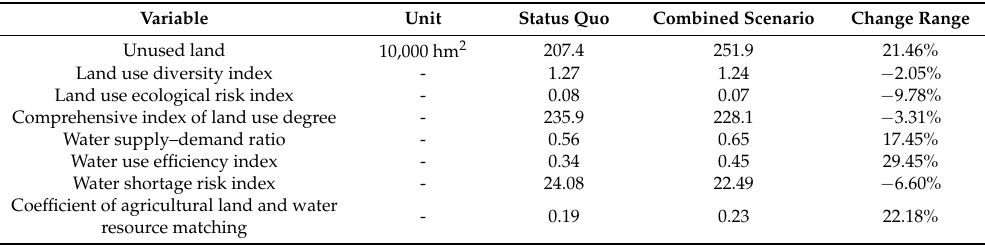
Table 4. Comparing the status quo with the system dynamics (SD) model results under the combined scenario in 2030 under an arid